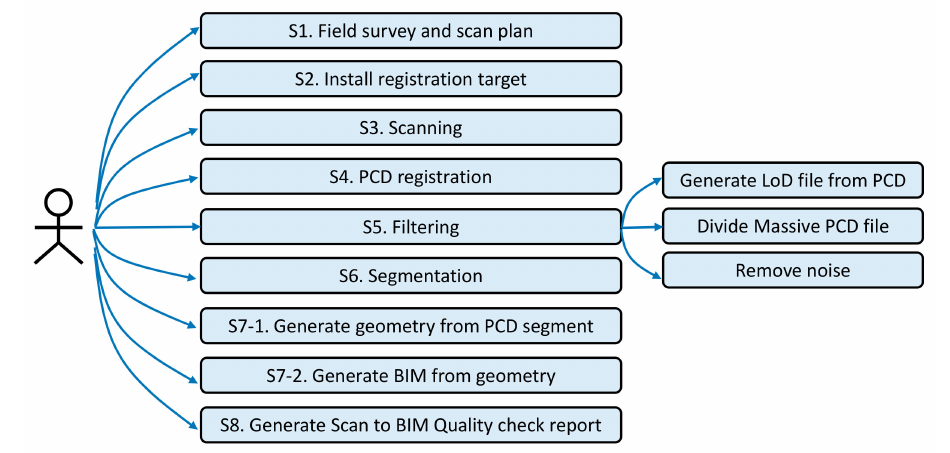
Figure 2. Use-case diagram.